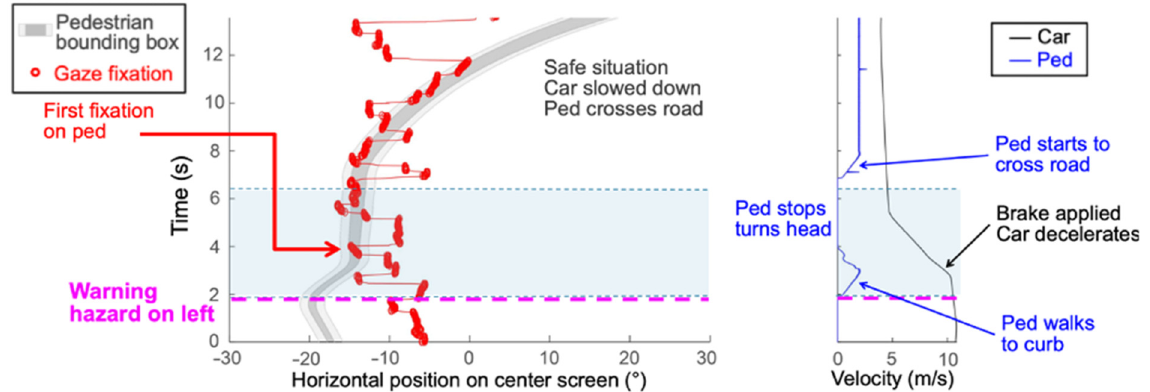
Figure A2. Data for a participant with a left HVFD for an event in which a human-controlled pedestrian (HCped) crosses from the left (blind) side of the participant in a drive when the ADAS was engaged. The pink horizontal line indicates the time of the ADAS trigger. Soon after the hazard warning, the participant scanned to the left, which led to an early fixation on the HCped and a safe street crossing. The participant decelerated gently, and the HCped crossed the street.